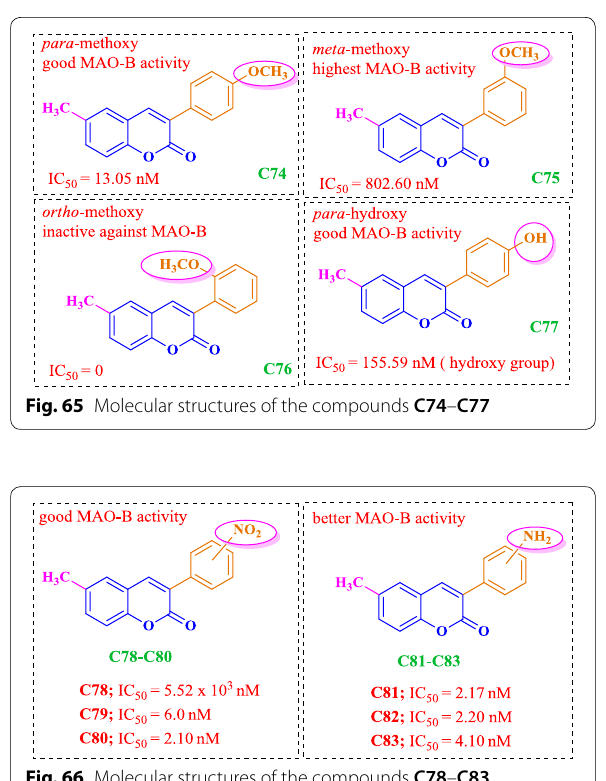
Fig. 66 Molecular structures of the compounds C78 – C83